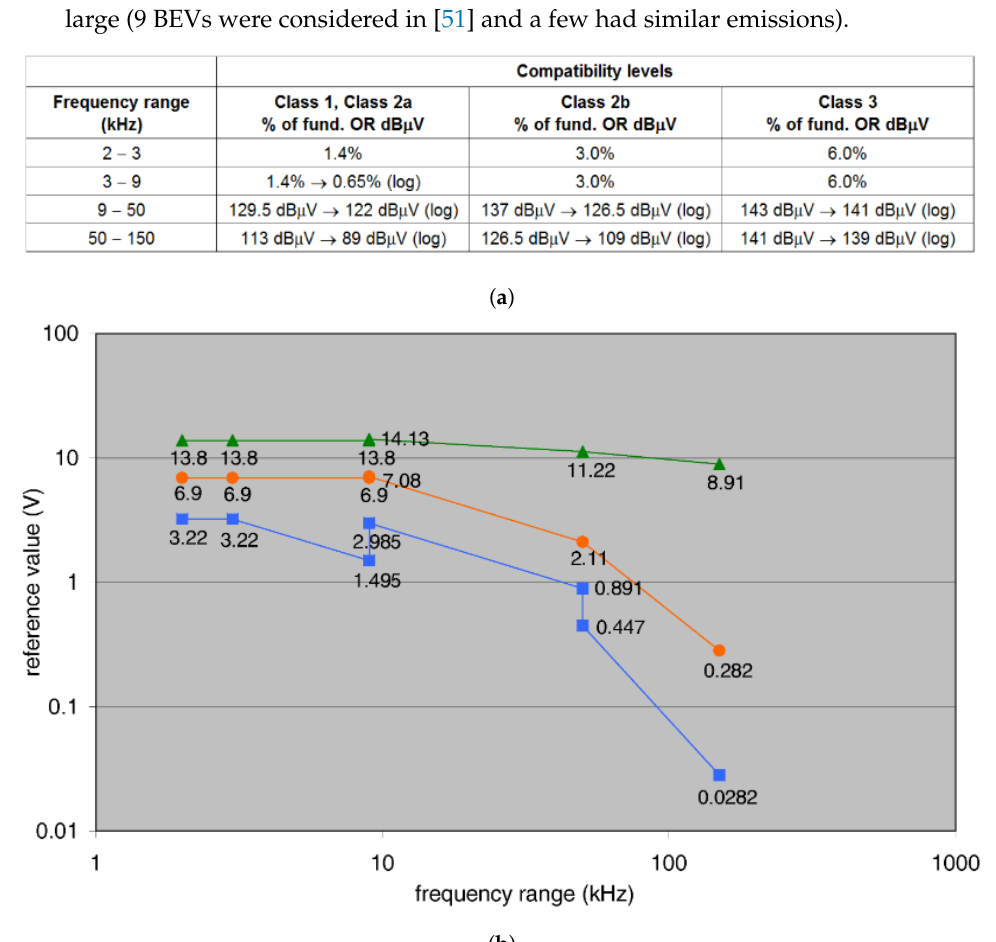
Figure 7. Supraharmonic distortion limits for LV distribution grids (distinguishing Protected, class 1, Residential/Office, class 2, and Industrial, class 3, environments, as in Tables 4 and 5 of IEC 61000-2-4): ( a ) numeric values, ( b ) graphical